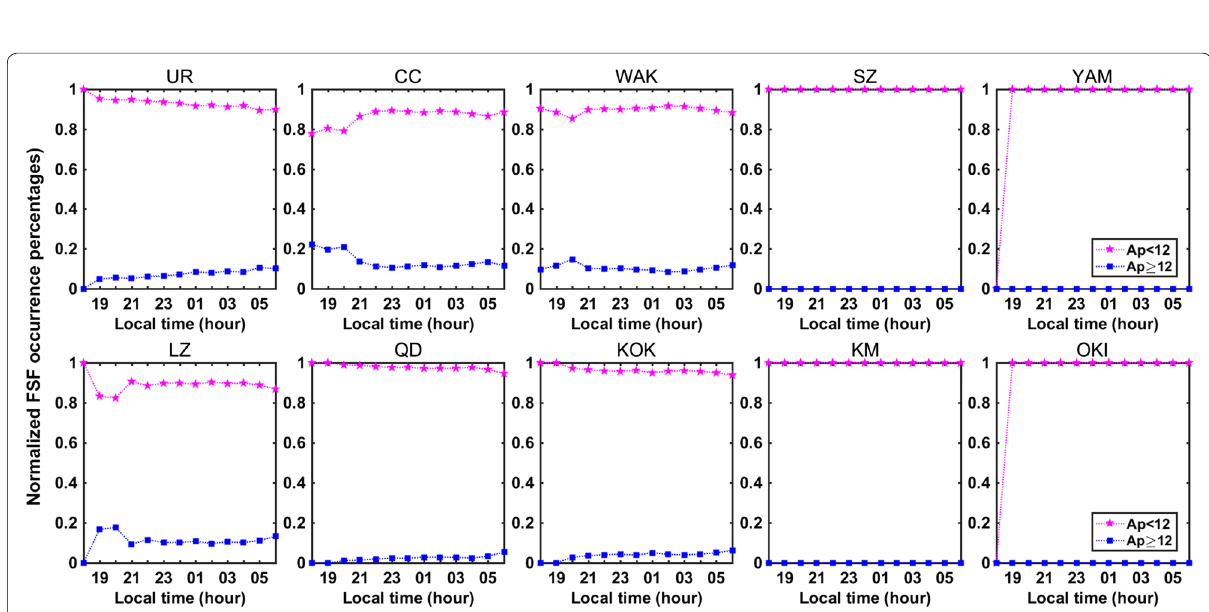
Fig. 5 Variations in normalized FSF occurrence percentages on different Ap index levels; magenta lines represent the low geomagnetic activity and blue lines represent the high geomagnetic